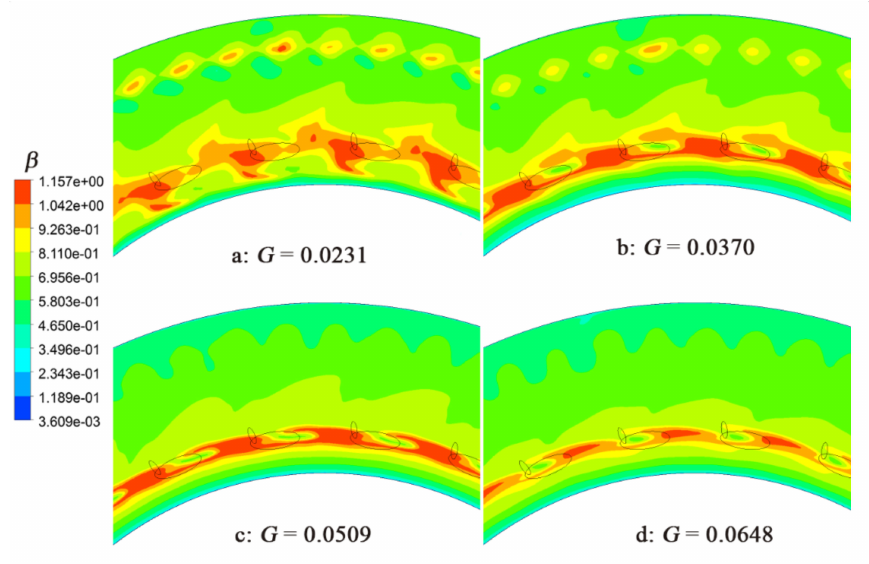
Figure 19. Contour of swirl ratio β at the plane z = 0.5 for different gap ratios: ( a ) G = 0.0231, ( b ) G = 0.0370, ( c ) G = 0.0509, ( d ) G =